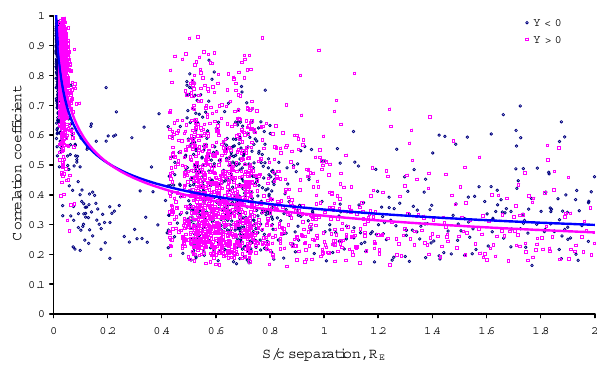
Fig. 9. Cross-correlation coefficients plotted vs the s/c separation for the dawn and dusk magnetosheaths. A full set of the events and power-law fits are presented up to 2 R E of s/c